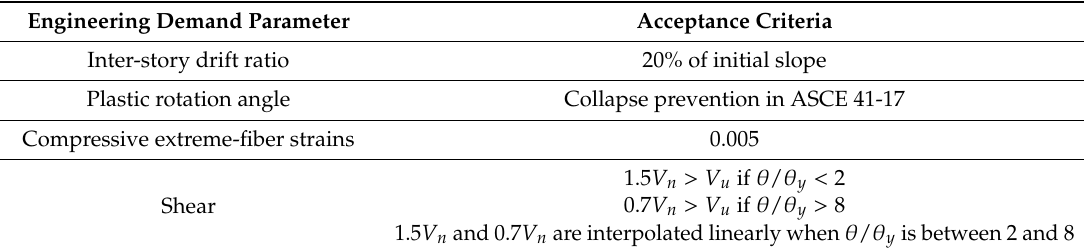
Table 9. Engineering demand parameters for seismic fragility